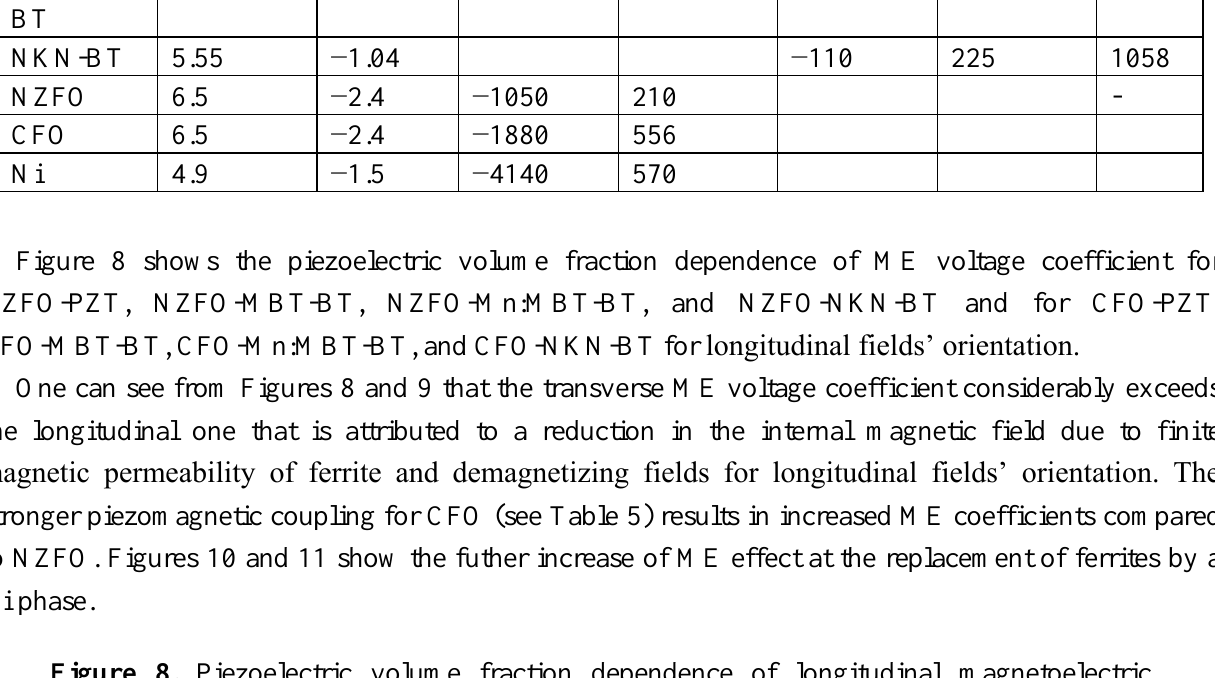
Figure 8. Piezoelectric volume fraction dependence of longitudinal magnetoelectric (ME) voltage coefficient for bilayers of NZFO and piezoelectrics (a) and CFO and piezoelectrics (b)